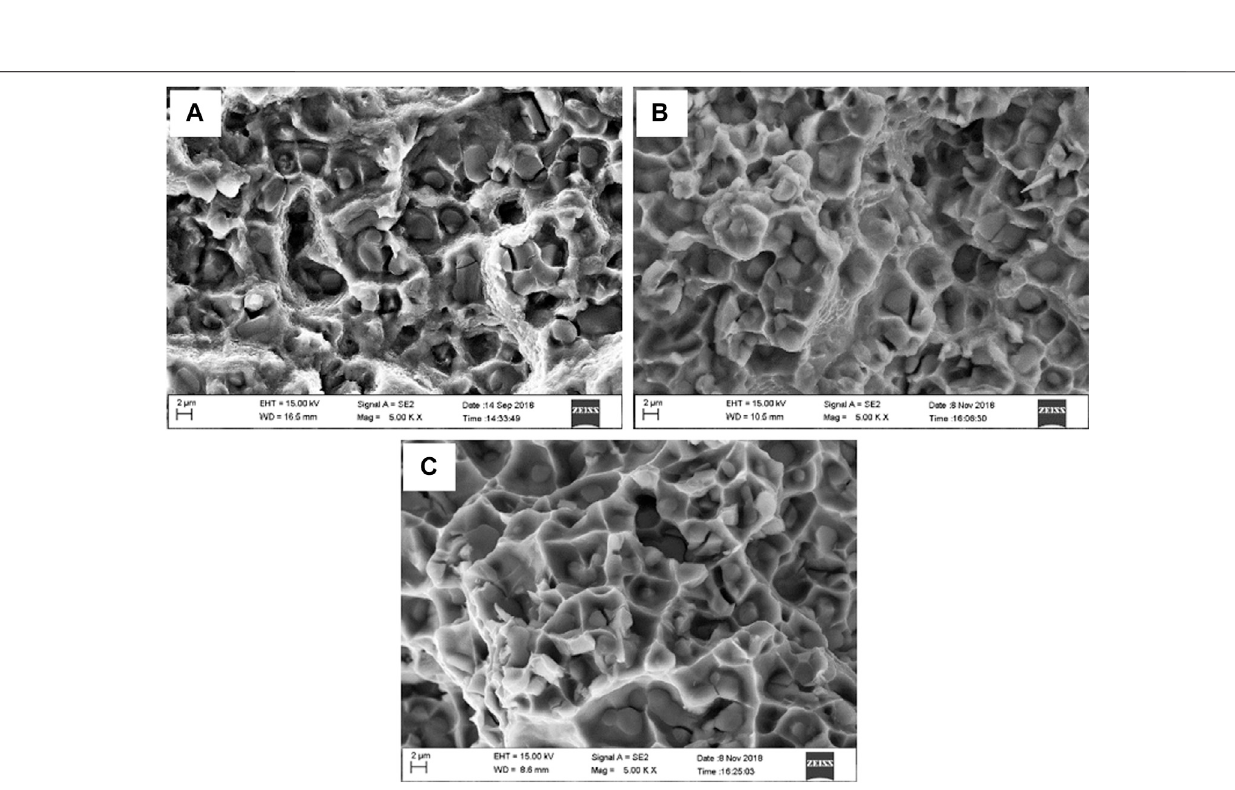
Frontiers in Materials |